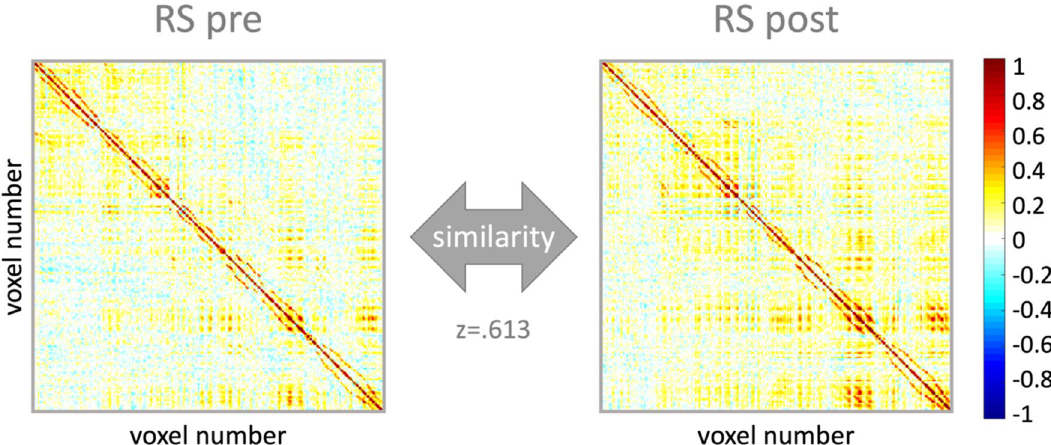
Figure 2. Multivoxel correlation structure (MVCS) for an exemplar ROI and participant. Each matrix depicts the correlation between each of the n voxels of the ROI with all the other voxels of the ROI during a specific fMRI run. The similarity between two matrices (here pre and post resting-state (RS) runs) is calculated as the r-to-z transformed correlation between the two MVCS. Resulting Z scores are compared between task and stimulation